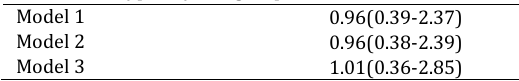
Applying Cox proportional hazard regression analysis with confounders adjustment in 3 models Model 1- adjustment for age and sex Model2-adjustments of cofounders of model 1 and also history of CVA, BMI, history of premature heart disease in family and Smoking. euthyroid